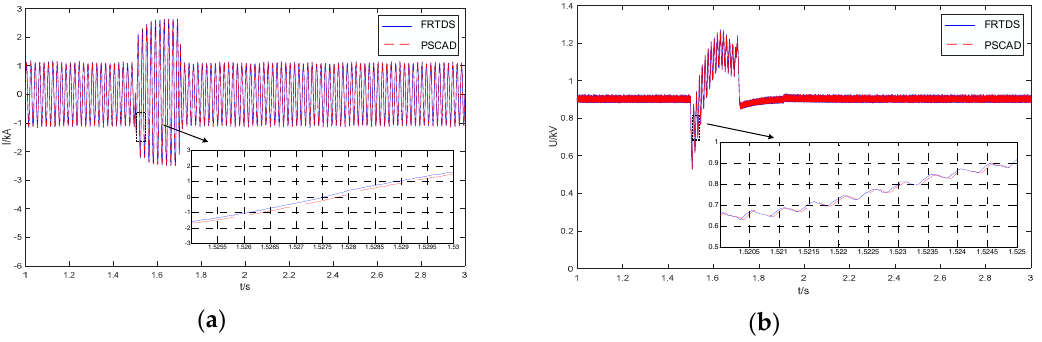
Figure 17. Simulation results of FRTDS and PSCAD: ( a ) the filter output a phase current; ( b ) inverter DC side voltage.